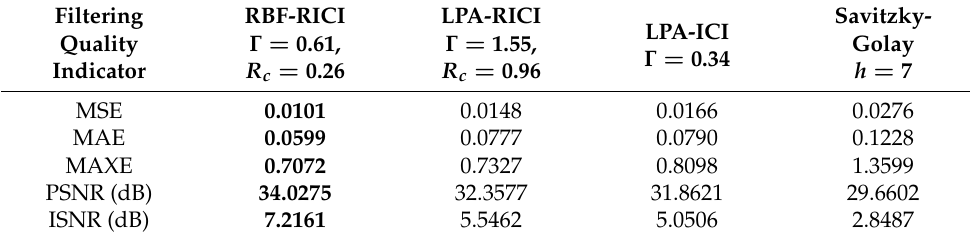
Table 10. Bumps signal (SNR = 10 dB)—Filtering results.